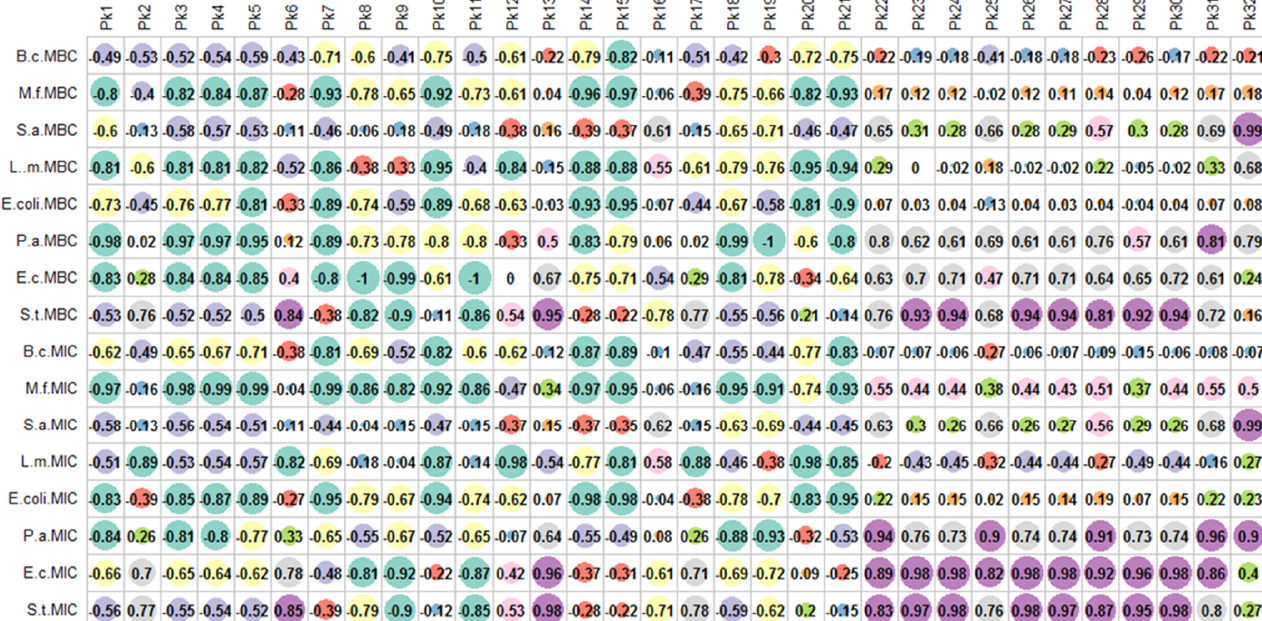
The results of multi-block discriminant analysis considering parts and extraction sol- vents as class membership criteria were graphically shown in Figure 5A. looking at the both scatterplots of samples, it is possible to view a quite clear separation among the two parts and extraction solvents, respectively, except the block “Antioxidant Properties” wherein no segregation between the leaves and stem bark was obtained (Figure 5A,B). For the first model (parts), 2 functions, were sufficient to discriminate the two parts for the block “Enzymes Inhibition” and “Antibacterial Activity” while 1 functions, was sufficient to separate the two parts for the block “Antifungal Activity” (Figure 6A). Regarding the block “Antioxidant Properties”, an AUC value of 0.63 was obtained considering 2 func- tions, suggesting no significant difference between both parts as regards the antioxidant activities (Figure 6A). Concerning the second model (extraction solvent), the optimal num- ber of functions was found to be 1 for the all the blocks (Figure 6B). Figure 5. Score plot of the multi-block discriminant analysis on P. kotschyi bioactive antioxidant, enzyme inhibitory, anti- fungal, and antibacterial activities. ( A ): Discrimination of the samples according to the parts. ( B ): Discrimination of the samples according to the solvents of extraction.